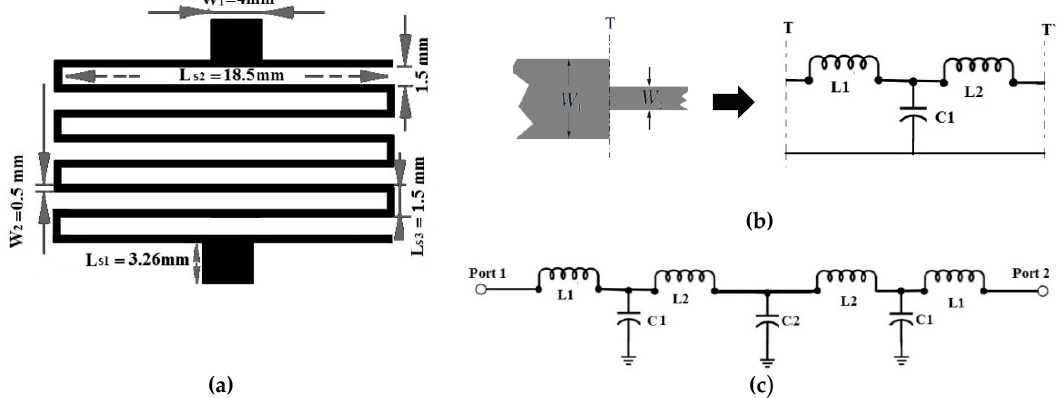
Figure 2. (a) Layout of the proposed e-textile meander microstrip line. ( b) Capacitance and Figure 2. ( a ) Layout of the proposed e-textile meander microstrip line. ( b ) Capacitance and inductances inductances of the equivalent circuits for the subnetworks for symmetrical steps. (c) Equivalent of the equivalent circuits for the subnetworks for symmetrical steps. ( c ) Equivalent circuit model circuit model of network. of